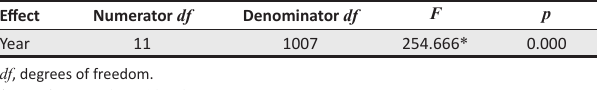
TABLE 6: Mixed-model analysis of variance results for the mean total Broad-Based Black Economic Empowerment